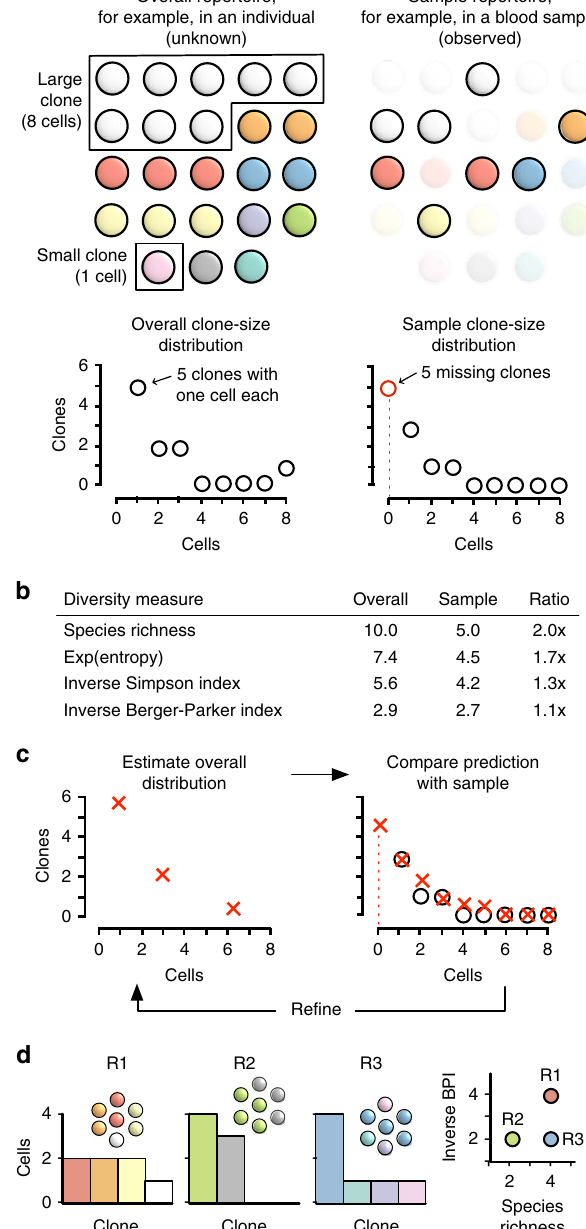
Figure 1 | Overall repertoires versus samples. ( a ) An overall repertoire (top left) and a random sample of this repertoire (top right), together with respective clone-size distributions from the overall repertoire and sample (bottom). Each circle denotes a cell; different colours denote different clones. Note that five clones are missing from the sample entirely, represented by the open red circle at a clone size of zero in the sample clone-size distribution. ( b ) Sample diversity underrepresents overall diversity across a range of diversity measures. ( c ) Recon reconstructs the overall repertoire by estimating the number of missing clones and iteratively updating until the predicted clone-size distribution in the sample (red crosses) matches the observed clone-size distribution in the sample (open circles), stopping short of overfitting. ( d ) Different diversity measures are complementary. Repertoires R1, R2 and R3 each have a total of 7 cells. R1 and R3 have the same species richness but different inverse Berger–Parker index (BPI); R2 and R3 have the same BPI but different species